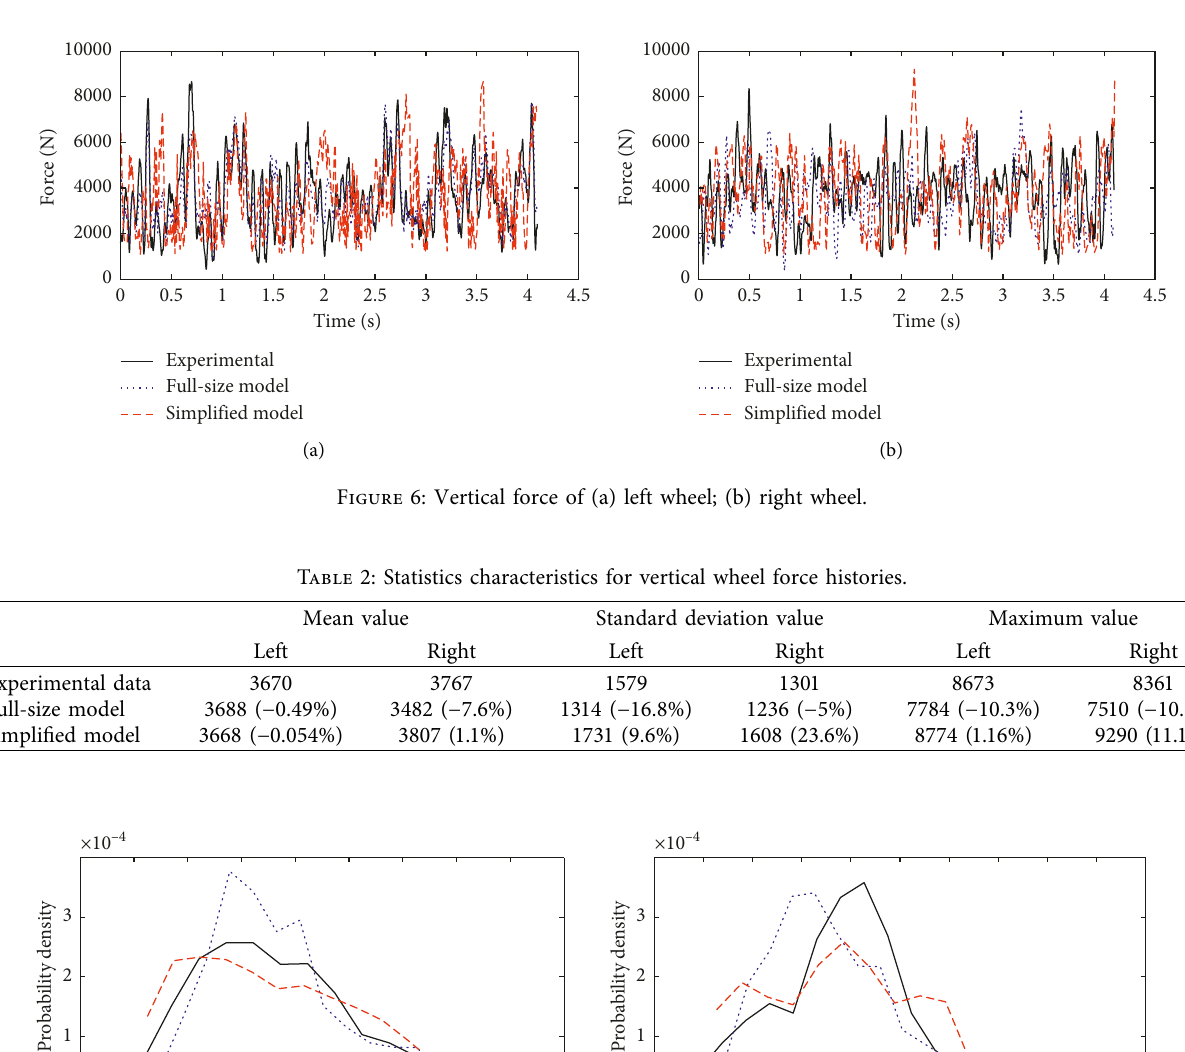
Figure 5: (a) Simplified multibody model; (b) complete full-size